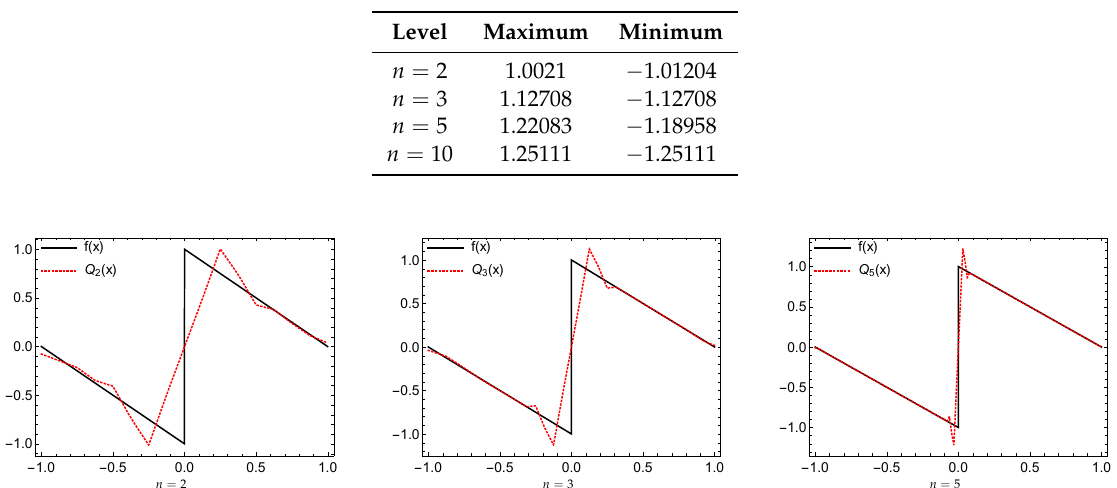
Figure 10. Graphs of Q sgn ( x ) by the B -splines of order 1 through 8, respectively. Table 2. Approximate maximum overshoot and undershoot in neighborhoods of x = 0 using Q n f of Example 2 for n = 2,3,5,10.